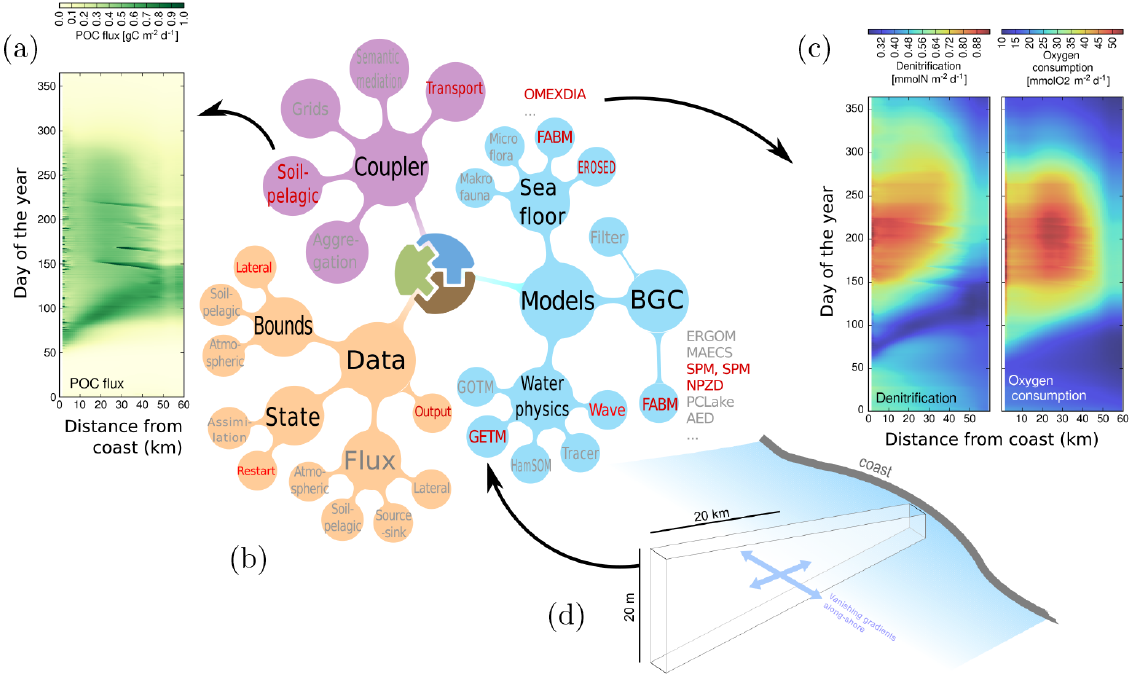
Figure 6. A 2-D idealised cross-shore transect off the German coastline is used to investigate the feedback loop among estuarine circulation, sediment transport, and nutrient cycling across the benthic–pelagic interface. (a, c) Hovmöller diagrams showing the soil–pelagic fluxes of particulate organic carbon (POC) and the soil BGC denitrification and oxygen consumption rates for the 60km long transect. (b) Coupling diagram including components for hydrodynamics, erosion–sedimentation, waves, pelagic ecology, suspended particles, and soil ecology. This example uses both ESMF modularity (the components) and FABM modularity (the different ecological–biogeochemical models within the pelagic and sediment environmental components). (d) Spatial set-up of the idealised 2-D cross-shore